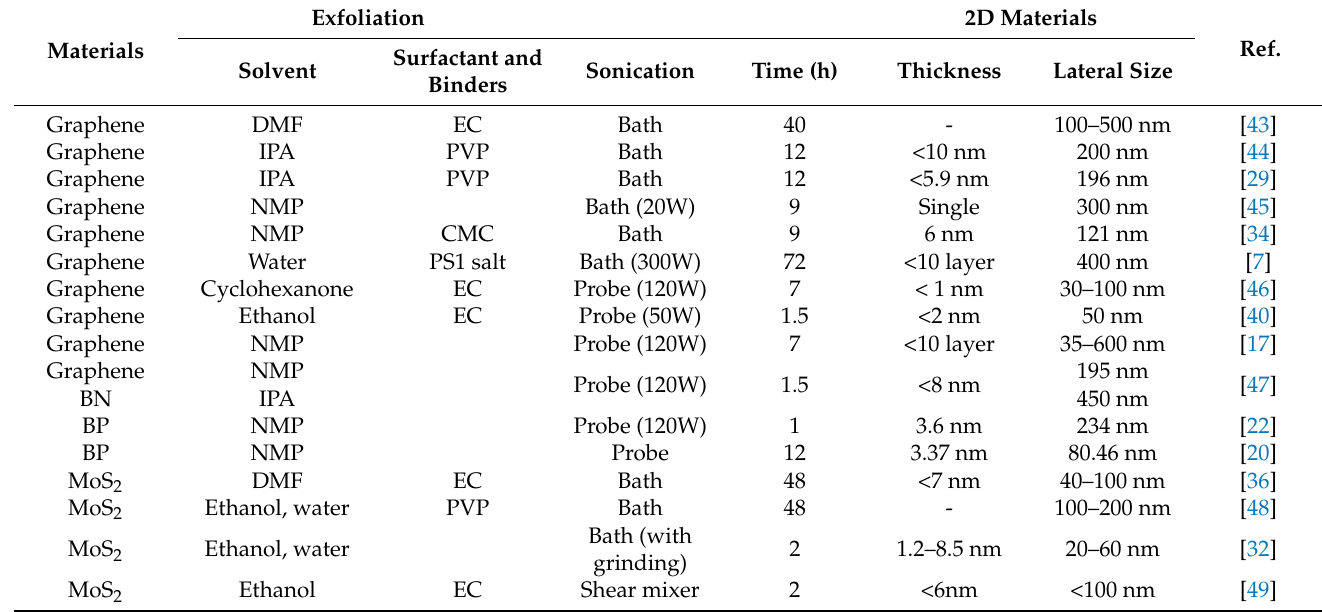
Table 1. Two-dimensional materials produced by